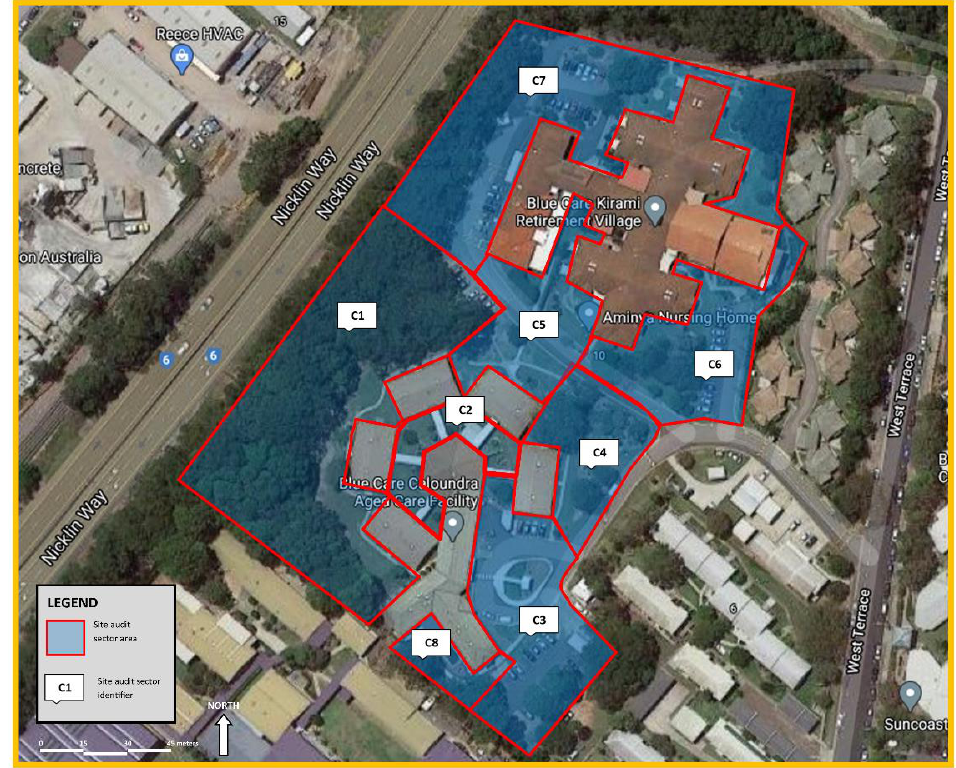
Figure 5. Caloundra Aged Care Facility site image with audit sector assignment (Image Source: Google Maps).